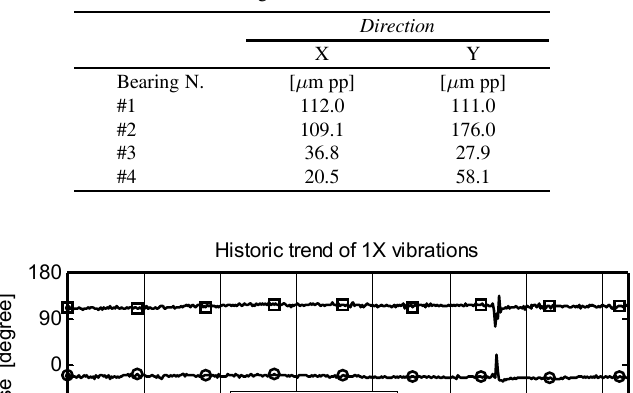
Table 5 Maximum levels of the overall amplitude of the HP-IP and LPturbine vibrations occurred at the end of the load rise carried out during the observation interval